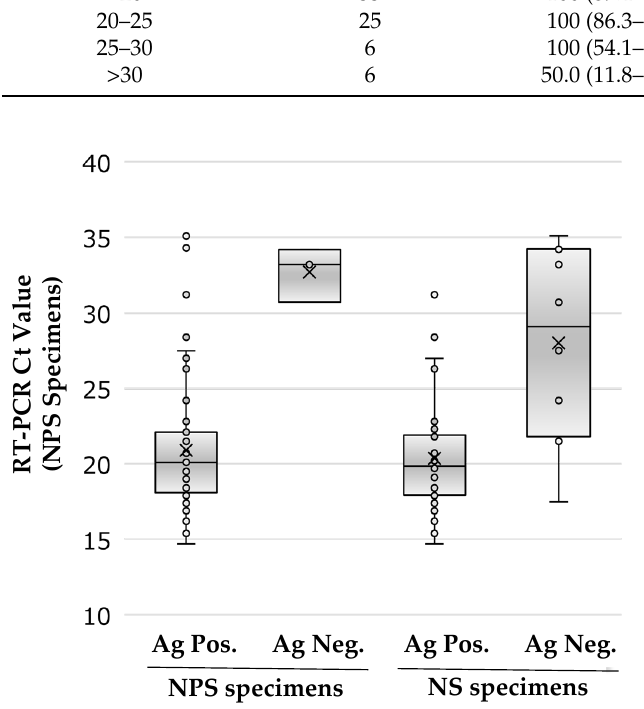
Figure 2. Antigen testing and RT-PCR results of all RT-PCR positive subjects. All antigen testing results for NPS and NS specimens are shown as Ct-value on the y -axis (left side: positive antigen testing (Ag Pos.) results; right side: negative antigen testing (Ag Neg.) results) and target specimens based on the antigen testing result on the x -axis. Each plot shows the results for each subject.